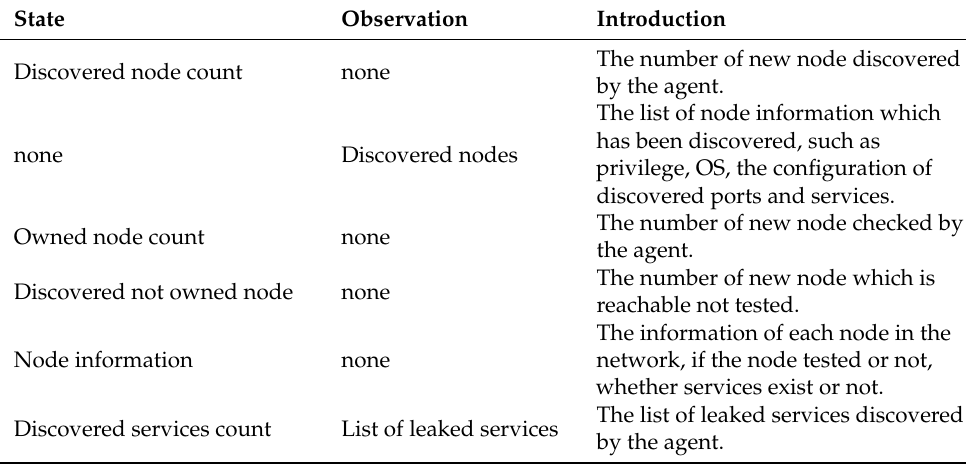
Table 4. The comparison of states and